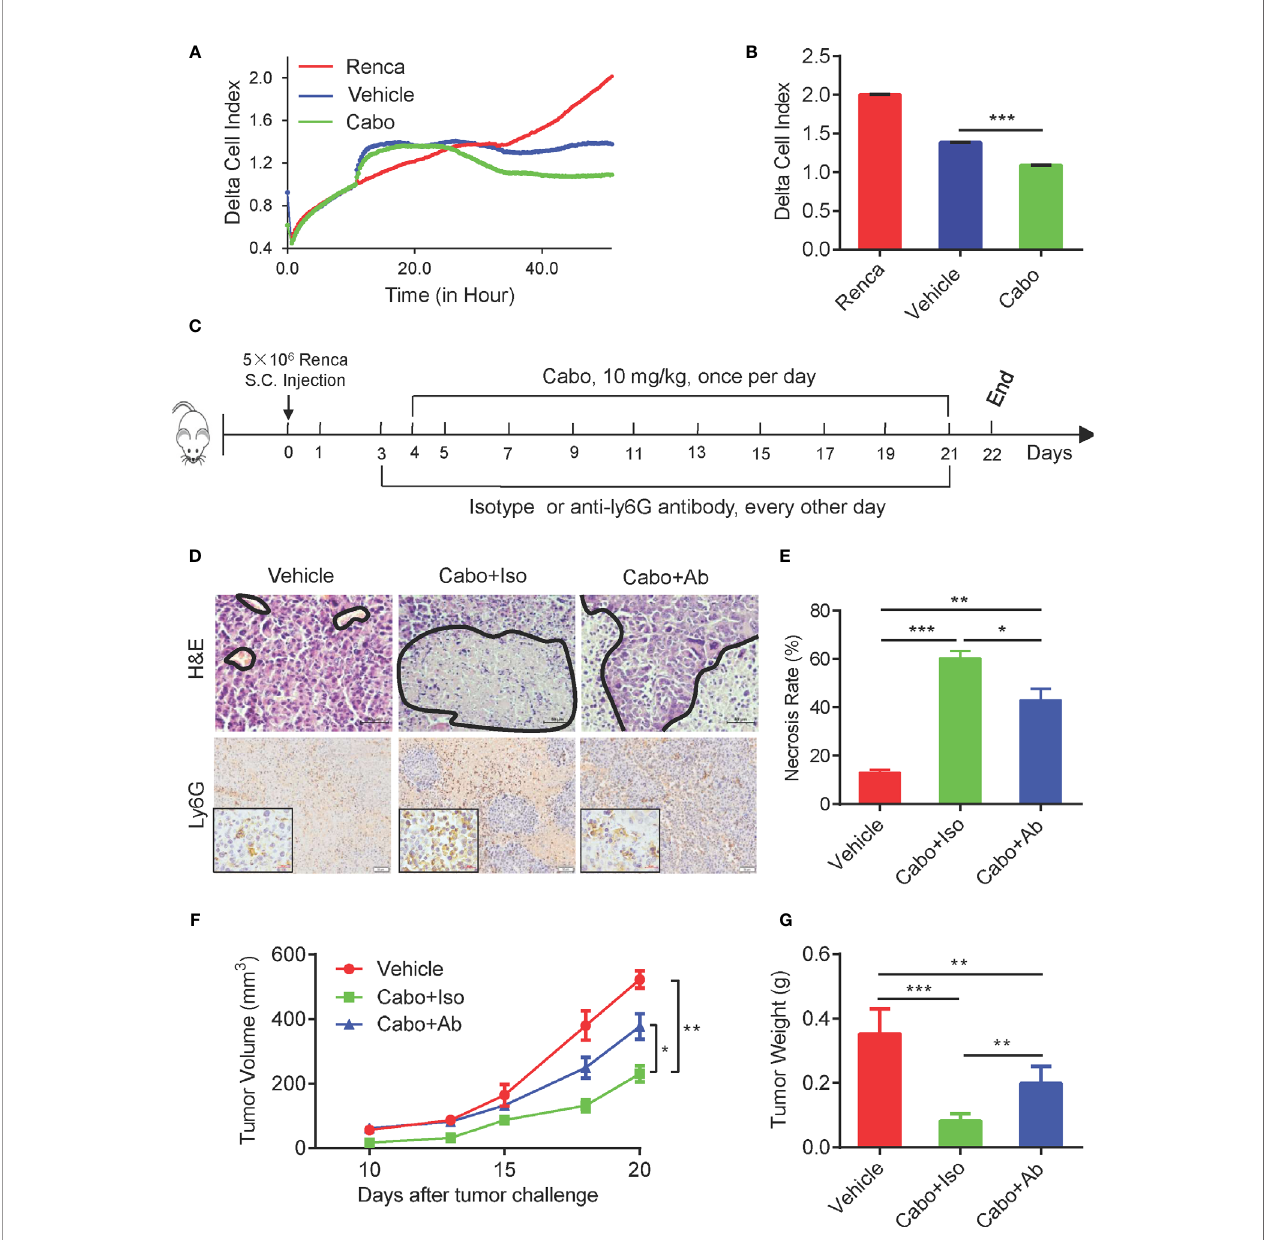
FIGURE 3 | The therapeutic effect of Cabozantinib is partially dependent on neutrophils. (A) Tumor growth inhibition effect of cabozantinib-primed neutrophils by RTCA. Mice were treated as in Figure 2A . At the end of the experiment, neutrophils were sorted from tumor tissues of vehicle and cabozantinib-treated mice for the ex vivo functional assay. Renca cells (1x10 4 cells/well) were seeded into the E-Plate of RTCA machine. When cells reached a logarithmic growth phase (approximately 10 hours), neutrophils were added into the E-Plate at an E:T ratio = 5:1. Proliferation of Renca cells was monitored in real time by RTCA (n=3 for biological replicate, and n=2 for technique replicate). (B) Statistical analysis of the cell index at the end of RTCA (50 hours). For A and B, experiments were repeated three times. (C) Schematic diagram showing treatments of mice. BALB/C mice were subcutaneous inoculated with Renca cells. Mice were then randomly assigned to 3 groups (n=6 mice per group): vehicle, cabozantinib + isotype control and cabozantinib + anti-Ly6G-depleting antibody at day 3 and anti-Ly6G-depleting antibody or its isotype control antibody (200 µg/mouse) was administered i.p. every other day. Cabozantinib (10 mg/kg) or vehicle was administered by gavage once per day, beginning on day 4. (D, E) Representative H&E (upper panel, the area encircled by the blue coil indicates necrotic tissue), and IHC (lower panel) staining results of tumor tissues, and quantitative analysis of necrotic area in tumor tissues. (F) Tumor growth curves during the experiment. (G) The average tumor weight of each group at the end of the experiments. Representative data of three independent experiments are shown (Vehicle, n=18; cabozantinib + isotype, n=18; cabozantinib + anti-Ly6G-depleting antibody, n=18 in total) with mean values ± SEM. * P <0.05, ** P <0.01, *** P <0.001 by unpaired